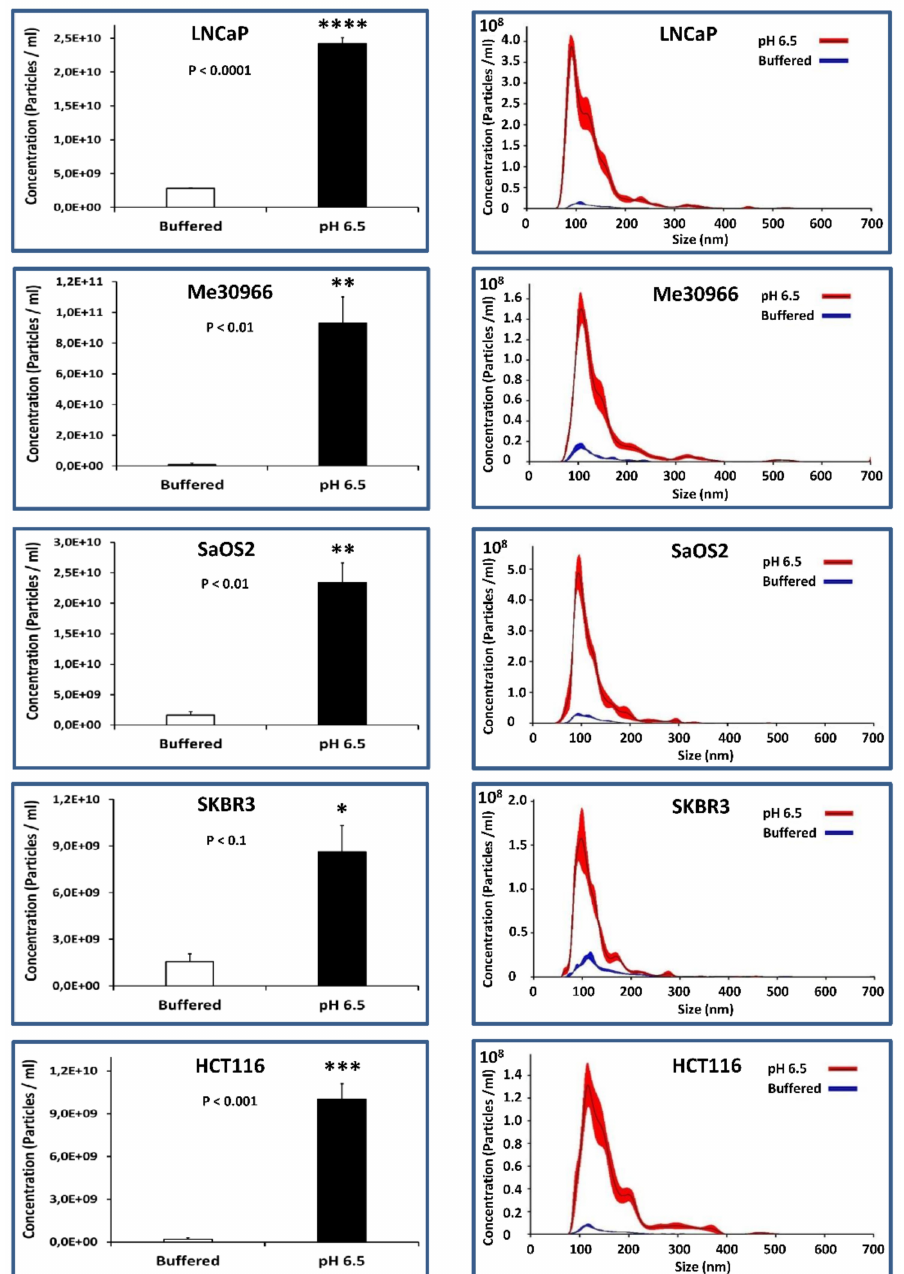
Figure 4. Nanoparticle tracking analysis (NTA) quantification of exosomes released from tumor cells cultured in buffered and pH 6.5 conditions. ( Left ) NTA analysis shows concentrations of particles isolated from cells in both culture conditions. Means ± SE of three different experiments are shown. The p -values were <0.1 in all cellular lines cultured in pH 6.5 with respect to buffered conditions. ( Right ) Overlay of the size, concentration, and distribution in both culture conditions. * p < 0.1, ** p < 0.01, *** p <